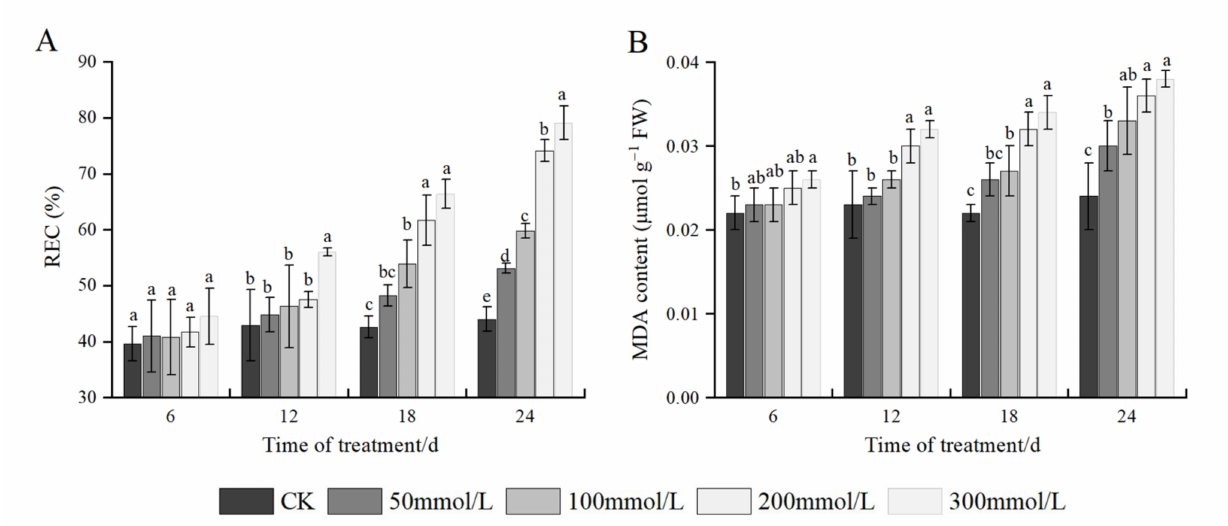
Figure 3. Effect of salt stress on ( A ) relative electrical conductivity (REC), ( B ) malondialdehyde (MDA) content of J. microcarpa L. seedlings. Error bars indicate the SD of treatment means. Different letters on bars indicate significant differences among the treatments ( p <